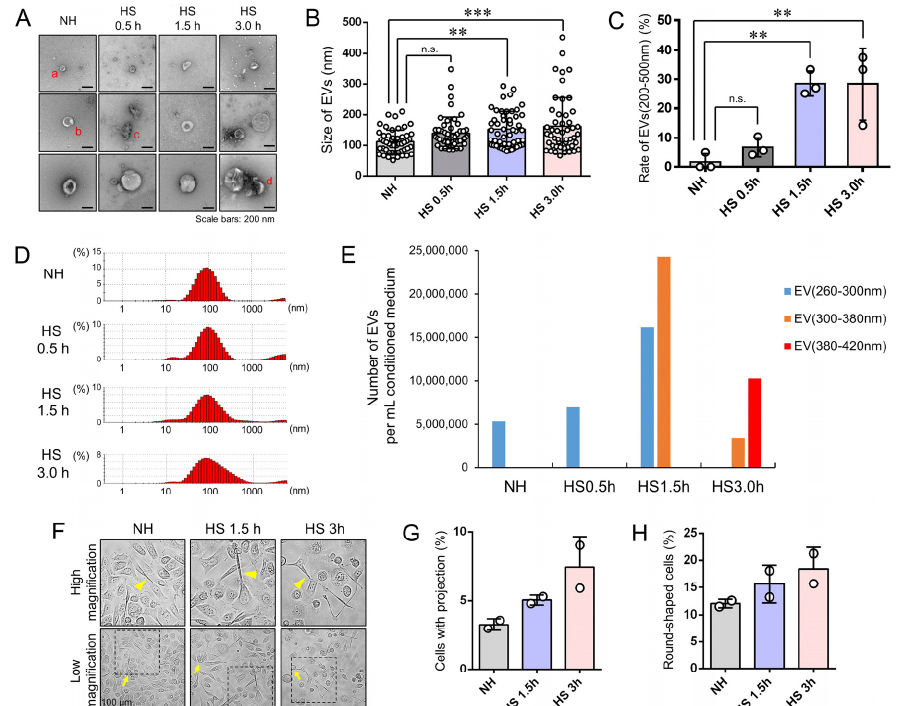
Figure 2 Figure 2. Release of EVs and membrane damage upon HSS. PC-3 cells were stimulated with HSS for 0.5, 1.5, or 3 h or NH, cultured for 24 h in serum-free media, from which EVs were then collected, and images were taken. ( A ) TEM images. ( a ), Cup-like EVs with clear walls of a potential lipid bilayer. ( b ), The wall of an EV was partially thick, which may be associated with another particle. ( c ), Membrane deformation was also seen in some EVs. ( d ), Crescent shapes are reminiscent of membrane brake of EVs. Scale bar, 100 nm. ( B ) Column scatterplot analysis of particle size. n = 50, mean ± SD. ANOVA and Tukey’s multiple comparison test was performed for statistics. ** p < 0.01, *** p < 0.001 (vs. NH); n.s., not significant. ( C ) Column scatterplot analysis of the rate of EV(200–500 nm) upon HSS. n = 3 (random three fields), ** p < 0.01; n.s., not significant. ( D ) Particle diameter distribution analysis using Zetasizer. ( E ) Numbers of EVs(260–300 nm), EVs(300–380 nm), and EVs(380–420 nm) per mL conditioned medium. qNano analyzer was used for counting EVs. ( F – H ) Cell morphological changes upon stress. ( F ) Representative images of cells. Top images were enlarged ones from the squares in the bottom images. Arrows, round-shaped cells. Arrowheads, cells with projections (or spindle shape). Scale, 100 µ m. ( G ) Rate of cells with projections. ( H ) Rate of round-shaped